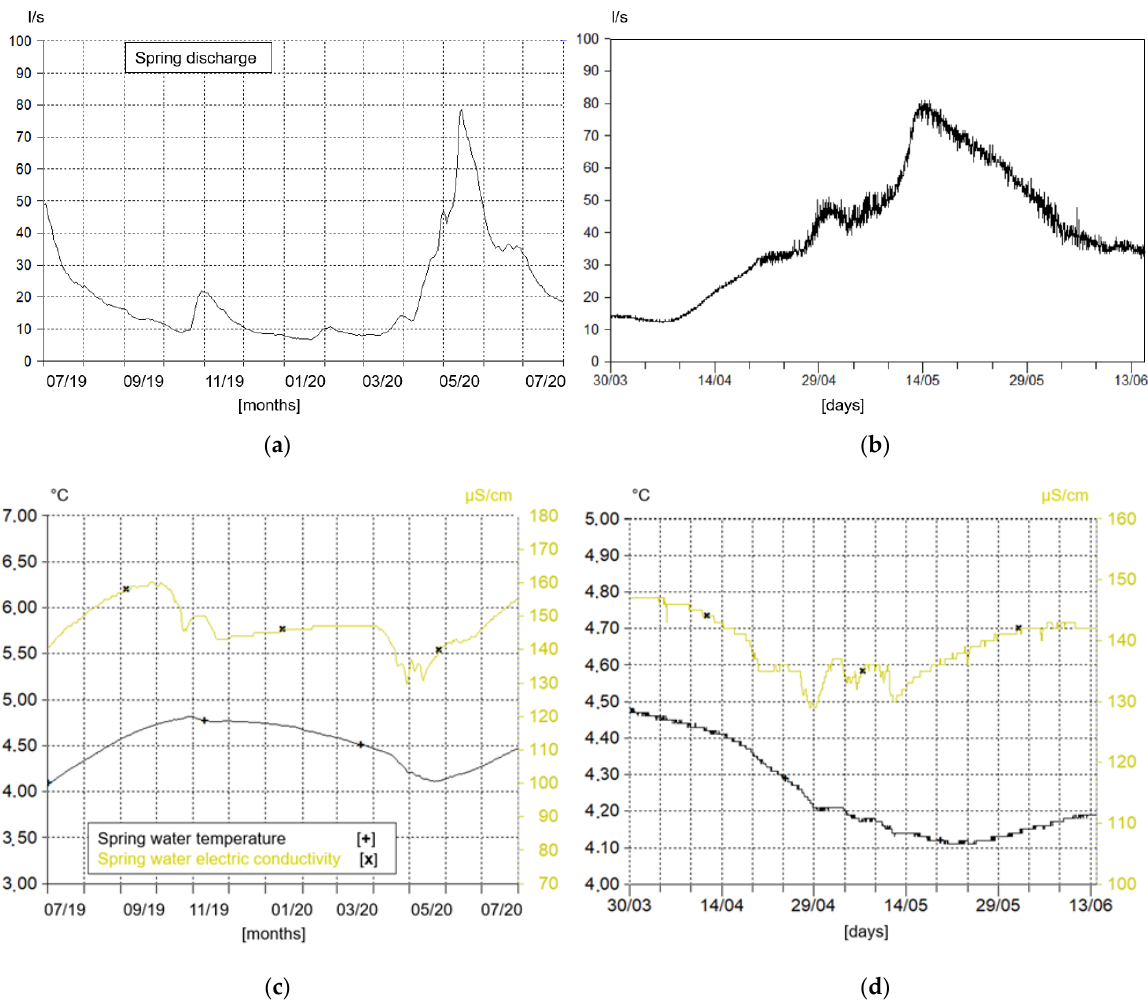
Figure 6. Graphs representing the parameters recorded from spring outflow sensor (Hydras 3 software layout): ( a , c ) Are day mean values; ( b , d ) Are the real values registered with the time interval of 1 h.